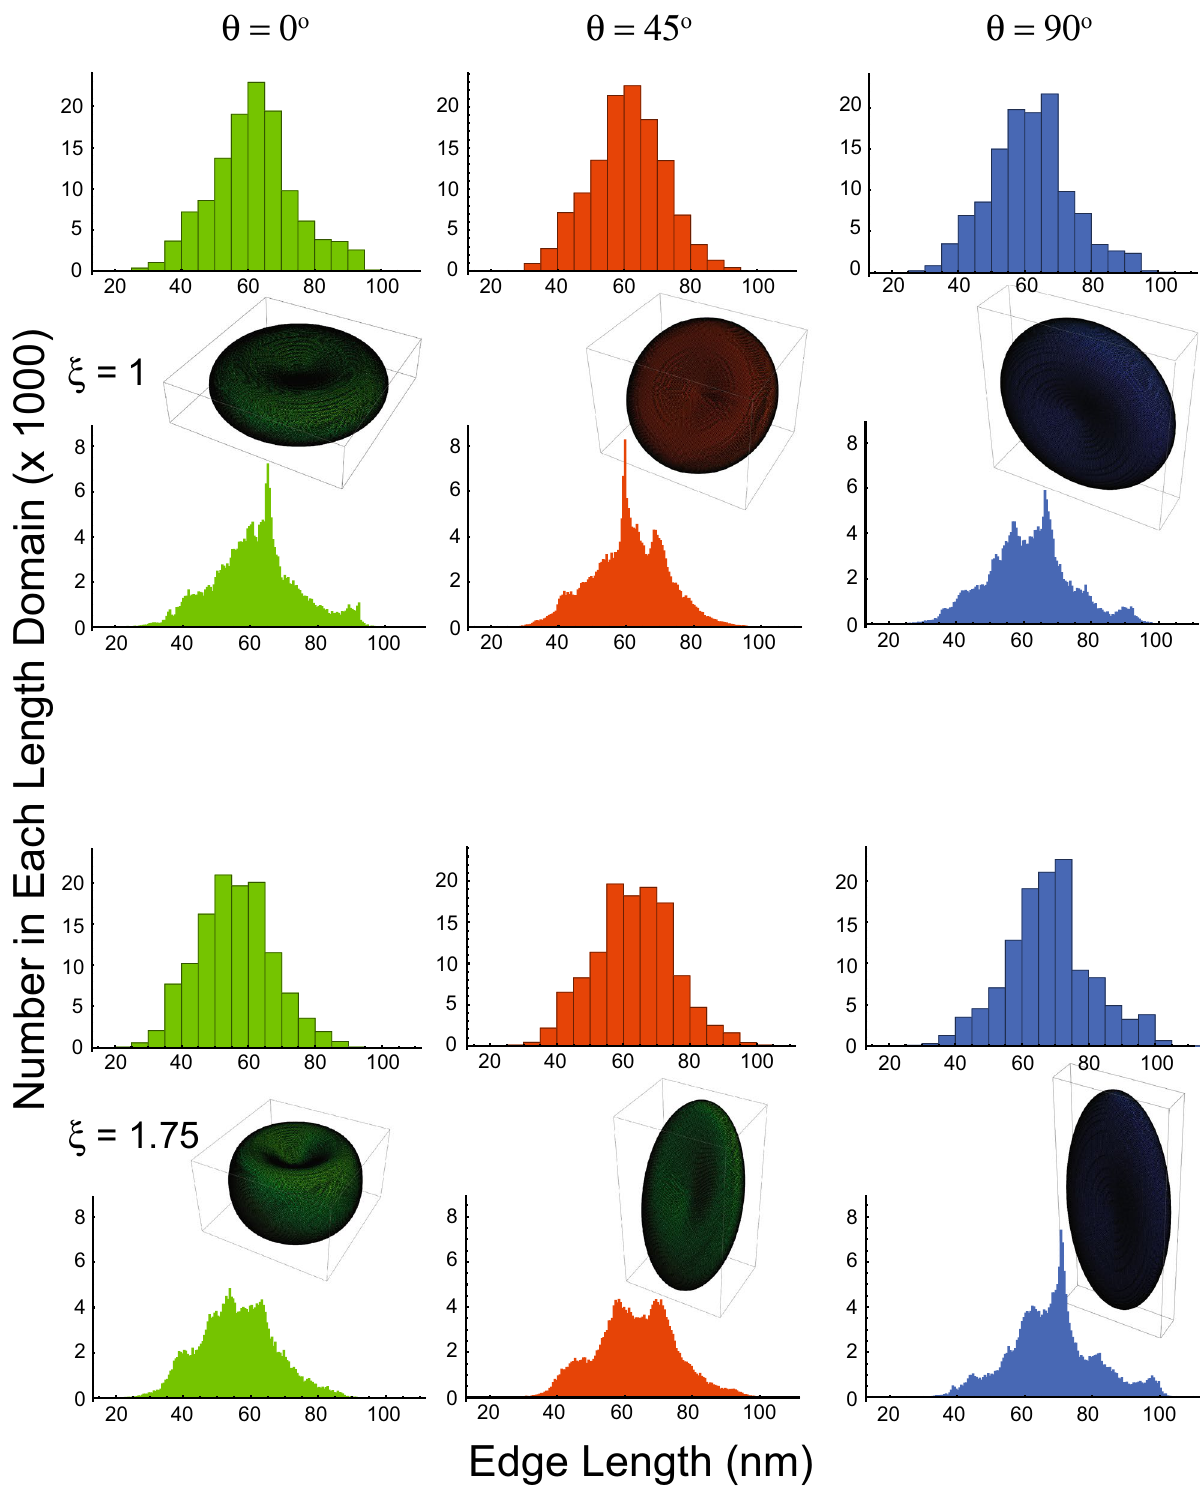
Figure 8. Histograms of the lengths of the 121,000 edges in the triangularization of an RBC at each of three rotations about the x -axis with no stretching (ξ = 1), and 75% stretching (ξ = 1.75). The colour coding was used to distinguish the three groups of data according to the rotations: green 0°, red 45°, and blue 90°. The bin numbers were 20 and 200 for the upper and lower pair of histograms at each value of stretching, ξ, respectively. The insets show the RBC shapes from which the histograms were made; they are the same as given in Figs. 4, S4 and